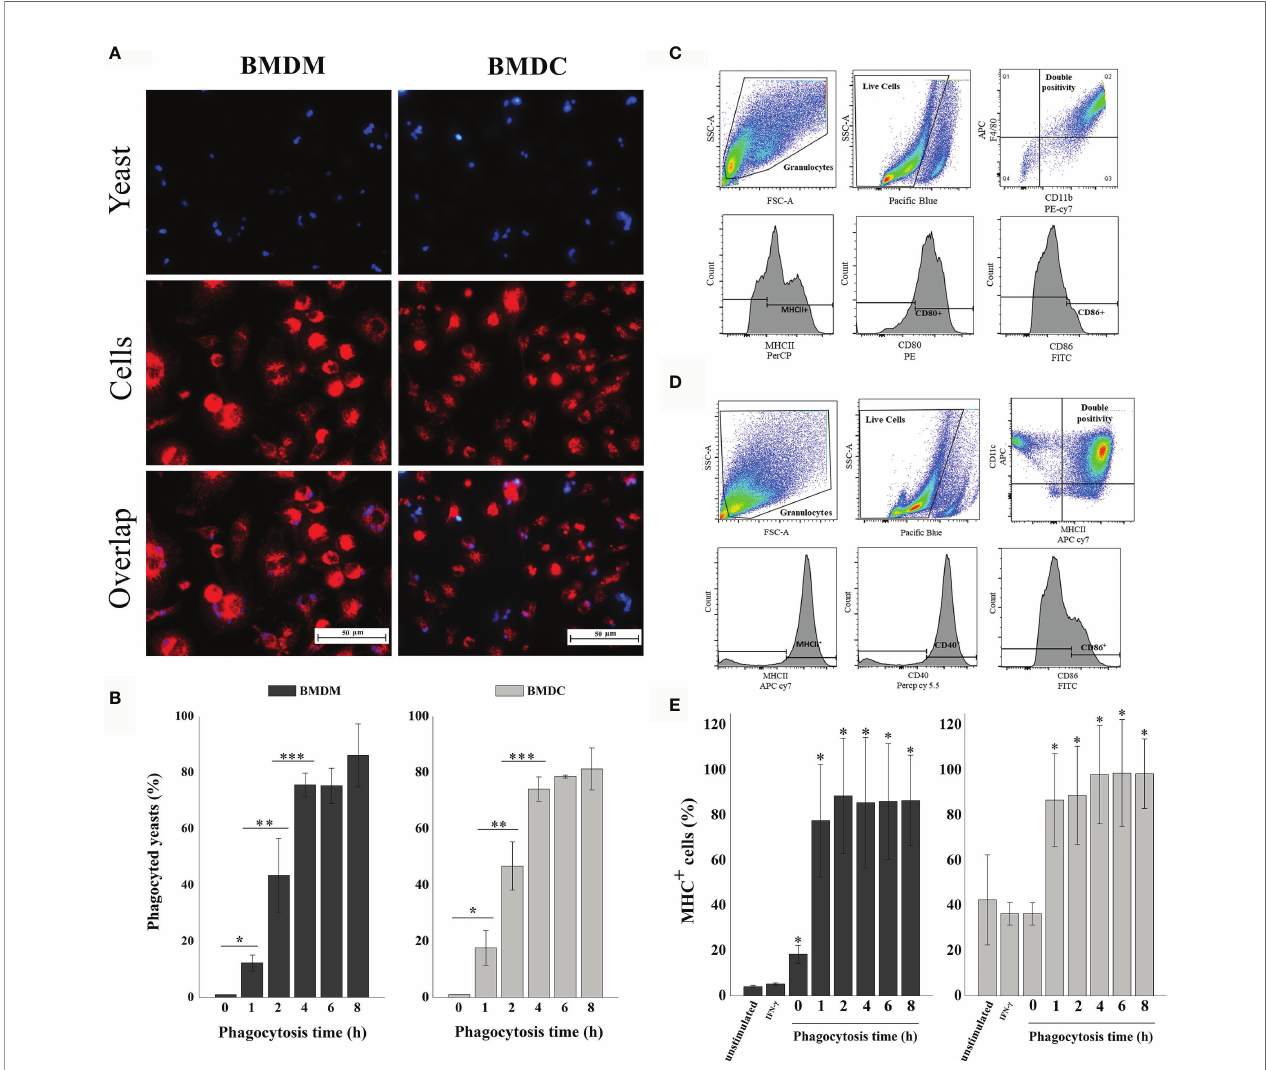
FIGURE 2 | Phagocytosis of H. capsulatum yeasts by murine BMDM and BMDCs. (A) Fluorescence microscopy of yeasts (blue) ingested by BMDM or BMDC (red). Overlap: Both images, with yeast and BMDM or BMDC, represent the same quadrant of the culture plate well according to the phagocytosis time determined of 4 hours. (B) Determination of the percentage of phagocyted cells. The percentage of cells ingested was determined by counting the samples stained with giemsa under a light microscope. *differ from zero time, **differ from one time, ***differ from two time by the Tukey ’ s test, p < 0.01. (C) Analysis strategy used for phenotyping and activation of BMDM. First, the cells were separated by granularity (SSC) and size (FSC), followed by live/dead - cell staining. Double positive cells for CD11b and F4/80 were classi fi ed as M j and analyzed for CD80, CD86 and MHC-II expression. (D) Analysis strategy used for phenotyping and activation of BMDCs. The cells were separated by granularity (SSC) and size (FSC), followed by live/dead - cell staining. Double positive cells for CD11c and MHC-II were classi fi ed as DCs and analyzed for CD40 and CD86 expression. (E) Percentage of MHC-II expression by BMDM or BMDC. Unstimulated cells, only stimulated with IFN- g and phagocytosis times of 0, 1, 2, 4, 6 and 8 hours. Unmarked, dead, and unstimulated cells were used as biological controls. *Differ from unstimulated control by the Tukey ’ s test, p<0.01. These results are representative of the biological